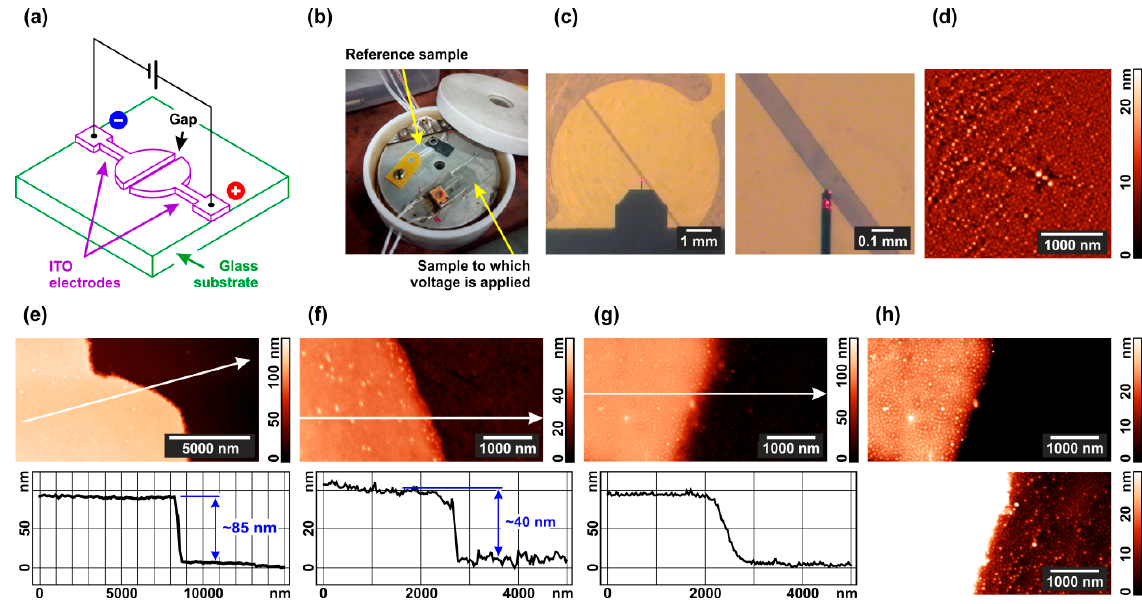
Figure 1. The experimental design and characterization of the samples: ( a ) Set-up schematic; ( b ) image of the cell for annealing under solvent vapor and electric field; ( c ) optical images of the ITO electrodes and the gap between them; ( d ) typical AFM image of the interelectrode space after spin-coating with a copolymer film; ( e ) AFM image and cross-section of the electrode edge before spin-coating; ( f ) AFM image and cross-section of a scratch made in the PS–P4VP film; ( g ) AFM image and cross-section of the electrode edge after spin-coating with a composite film; ( h ) typical topographic images of the composite film on ITO and glass after annealing in chloroform vapor without electric field. Height profiles in the Figures ( e – g ) are drawn along the arrows in the corresponding topographic images.